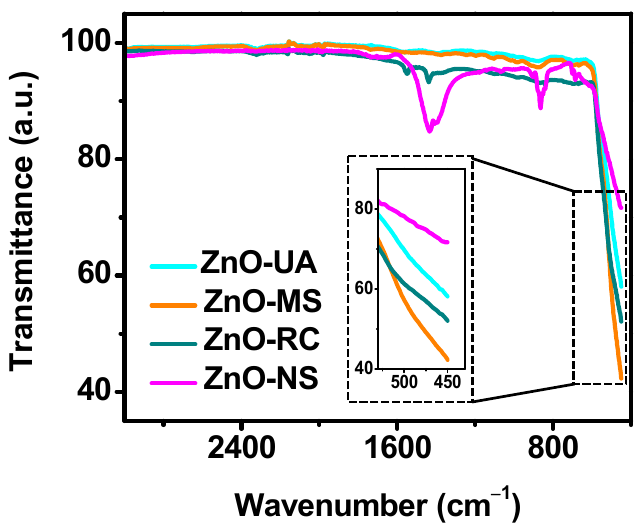
Figure 6. ATR-FTIR analysis of the ZnO NPs synthesized at different experimental conditions.